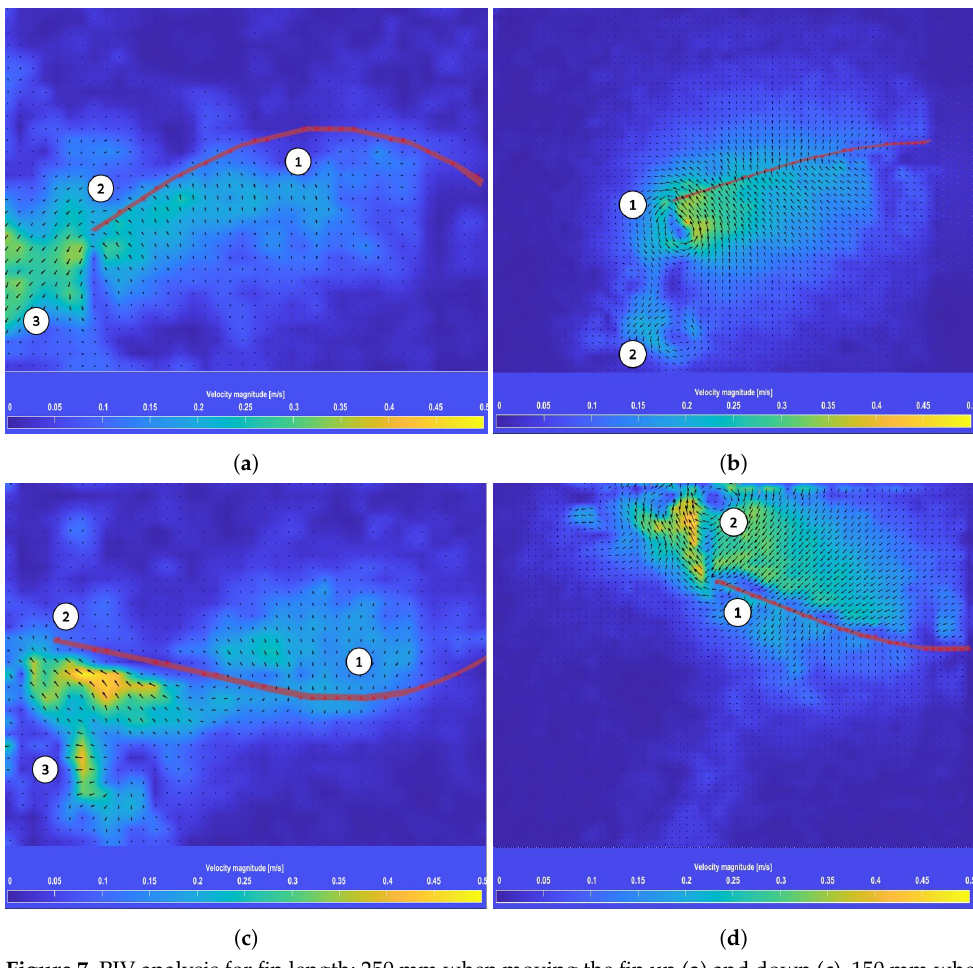
Figure 7. PIV analysis for fin length: 250 mm when moving the fin up ( a ) and down ( c ), 150 mm when moving the fin up ( b ) and down ( d